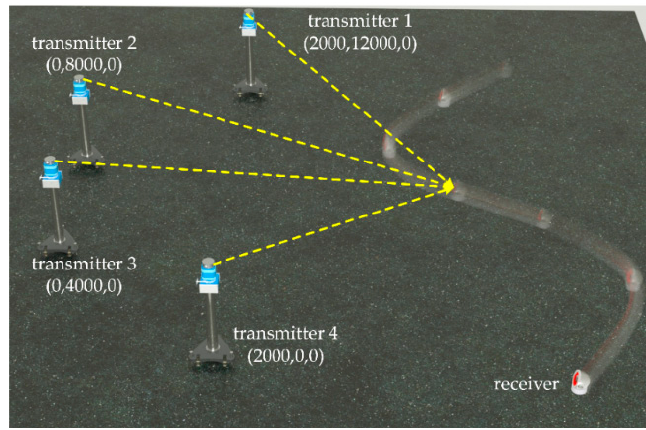
Figure 3. Configuration of simulation experiments.